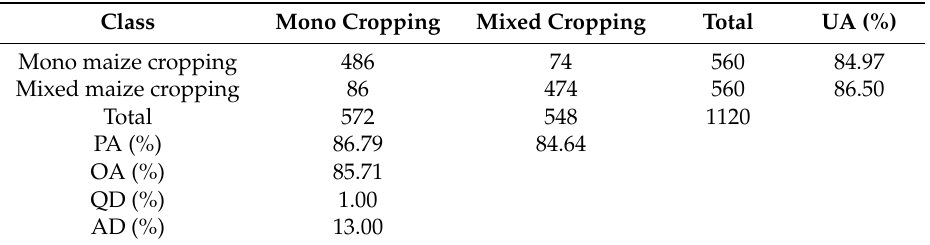
Table 5. Random forest classification confusion matrix for mapping cropping systems using the most important 15 RapidEye spectral variables and 30% of the reference